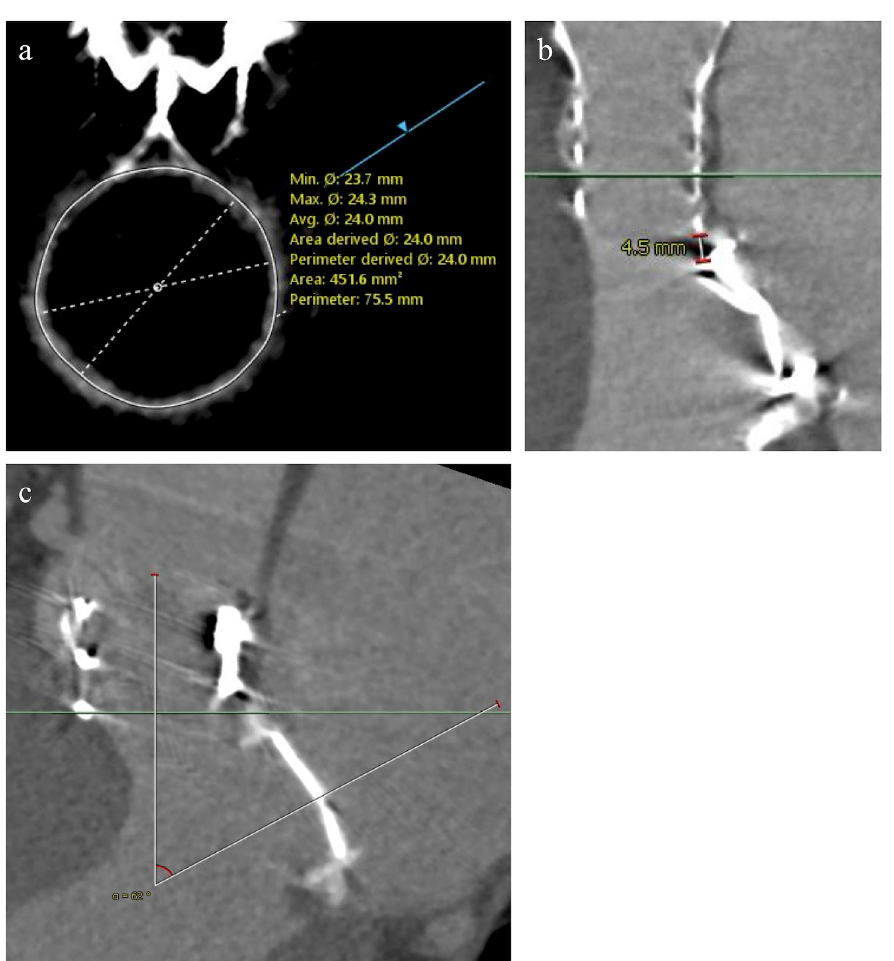
Fig 2. Postprocedural MDCT measurement. (a) Size of the mitral prosthesis housing. (b) The distance between the newly implanted THV and mitral prosthesis housing. (c) The angle between the mitral prosthesis and newly implanted THV. LVOT = left ventricular outflow tract; MDCT = multidetector computed tomography; THV = transcatheter heart valve.